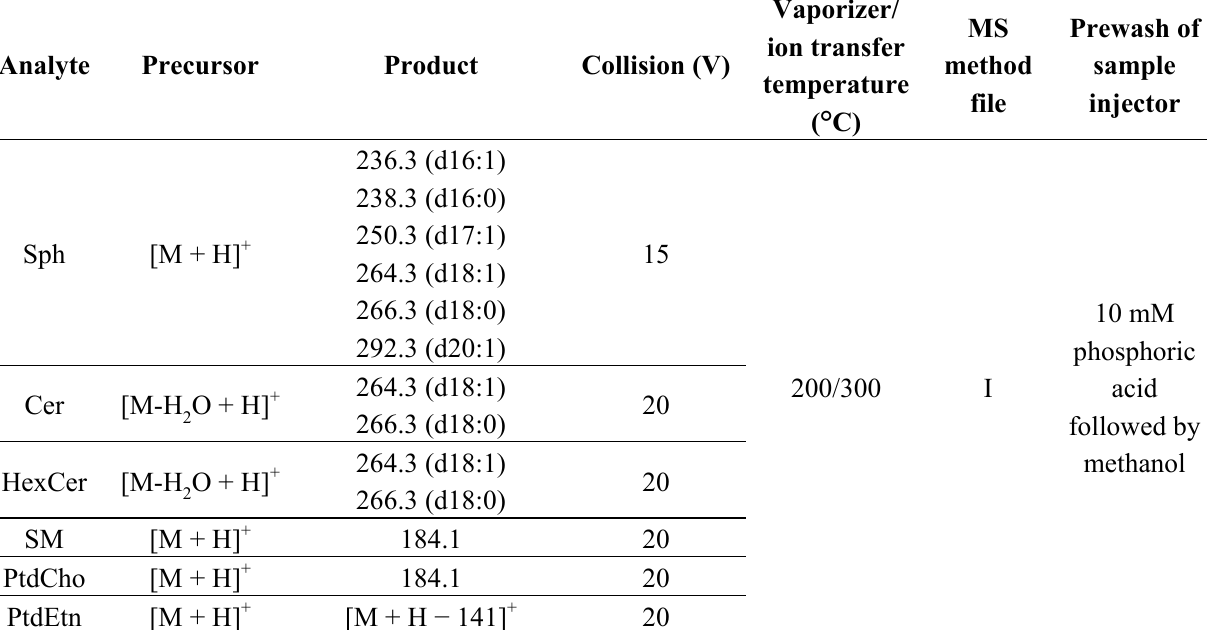
Table 1. Summary of the SRM parameters and LC sample injector